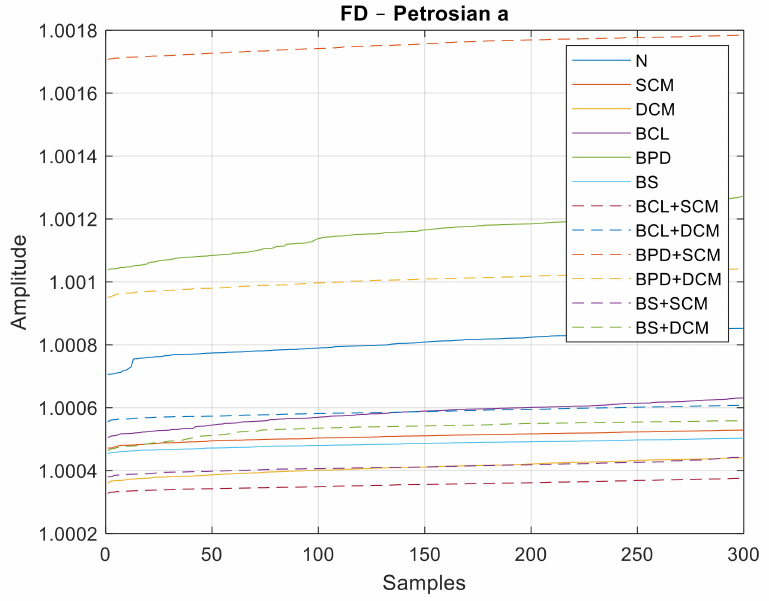
Figure 27. FD values for the Petrosian a